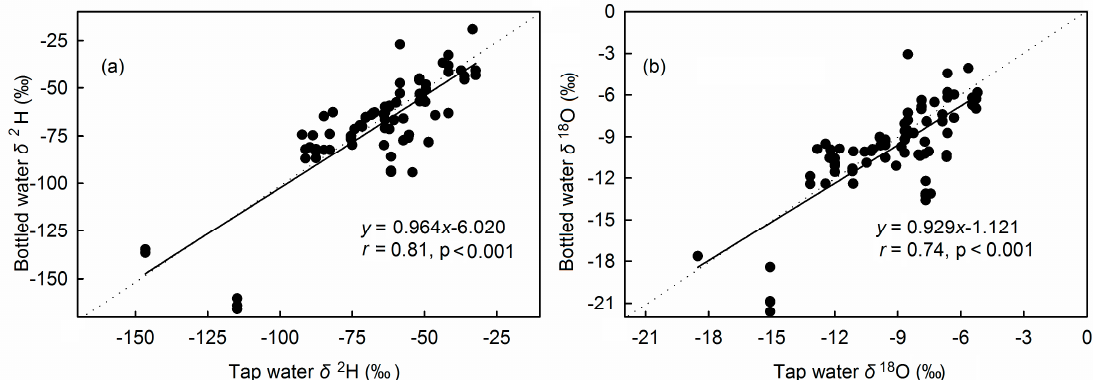
Figure 9. Correlation between δ 2 H ( a ) and δ 18 O ( b ) in bottled water and local tap water. From the tap water database provided by [27], 80 stations of tap water (Figure 1) adjacent to the origin of bottled water sites were examined. The dotted line is the line of equality (y = x).